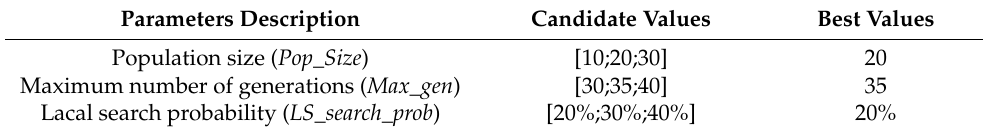
Table 14. Parameter tuning results for MA. Parameters